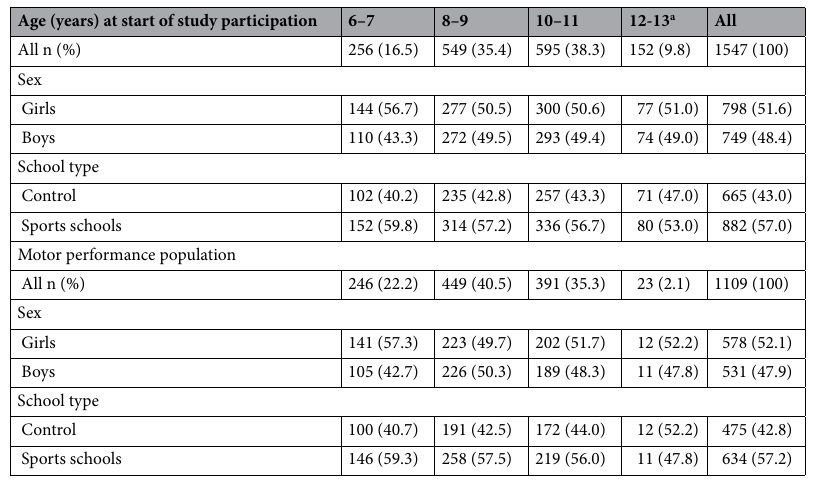
Table 1. Descriptive characteristics of this study’s participants by age (years) at start of study participation. a Including one child aged 14.